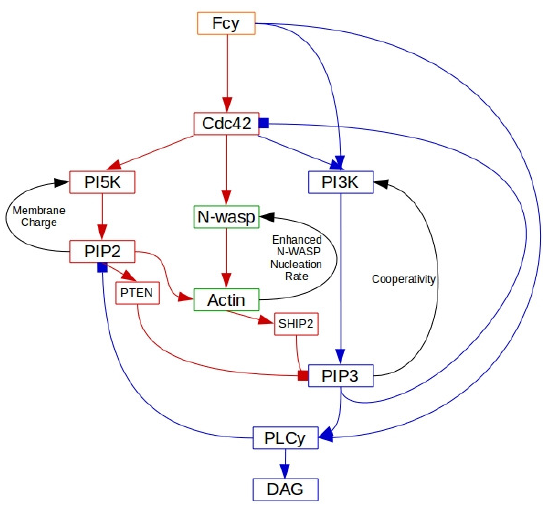
Figure 13. The signal-transduction steps following Fc γ R activation. From Ponce de Leon & Othmer